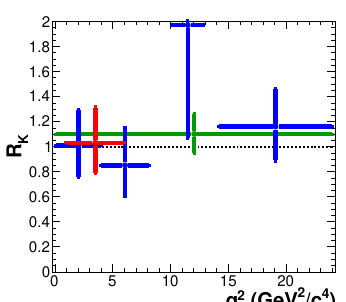
Figure 7. R K in bins of q 2 for B → K `` . The red marker represents the bin of 1 . 0 < q 2 < 6 . 0 GeV 2 / c 4 , and the blue marker are for 0 . 1 < q 2 < 4 . 0, 4 . 00 < q 2 < 8 . 12, 10 . 2 < q 2 < 12 . 8, and q 2 > 14 . 18 GeV 2 / c 4 bins. The green marker denotes the whole q 2 region excluding the charmonium